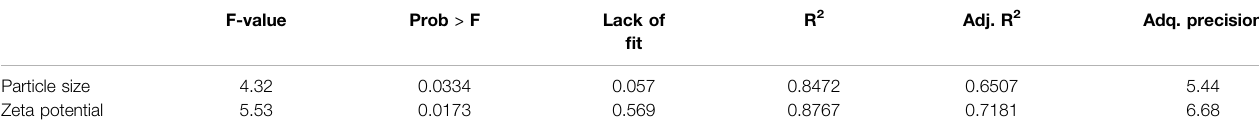
TABLE 2 | OXB-NEs optimization by Design-Expert ® .